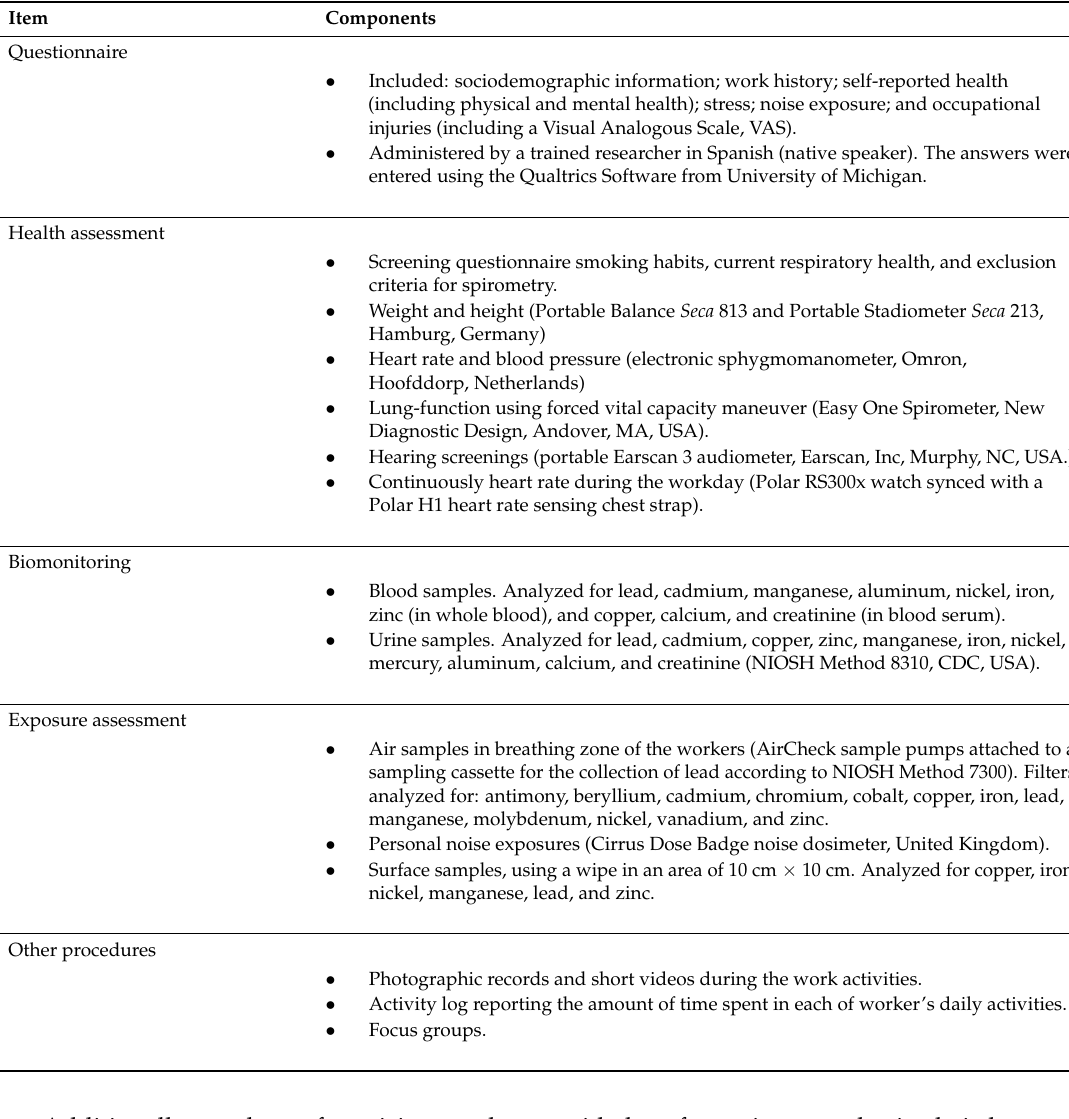
Table 1. Summary of participant